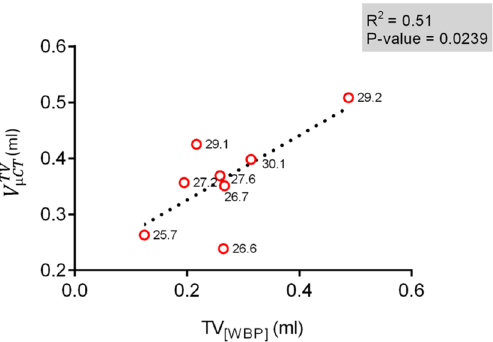
Figure 4. Correlation between lung volumes measured using micro-CT and WBP in living mice. Graph showing a weak positive correlation between TV [WBP] with V TV [ µ CT ] (R 2 = 0.5061) performed in-vivo (n = 8) using the correlative set-up. All points are labelled with the respective weights of the mice. The p values and respective coefficients of determination (R 2 ) from linear regression analysis is shown on the graph.